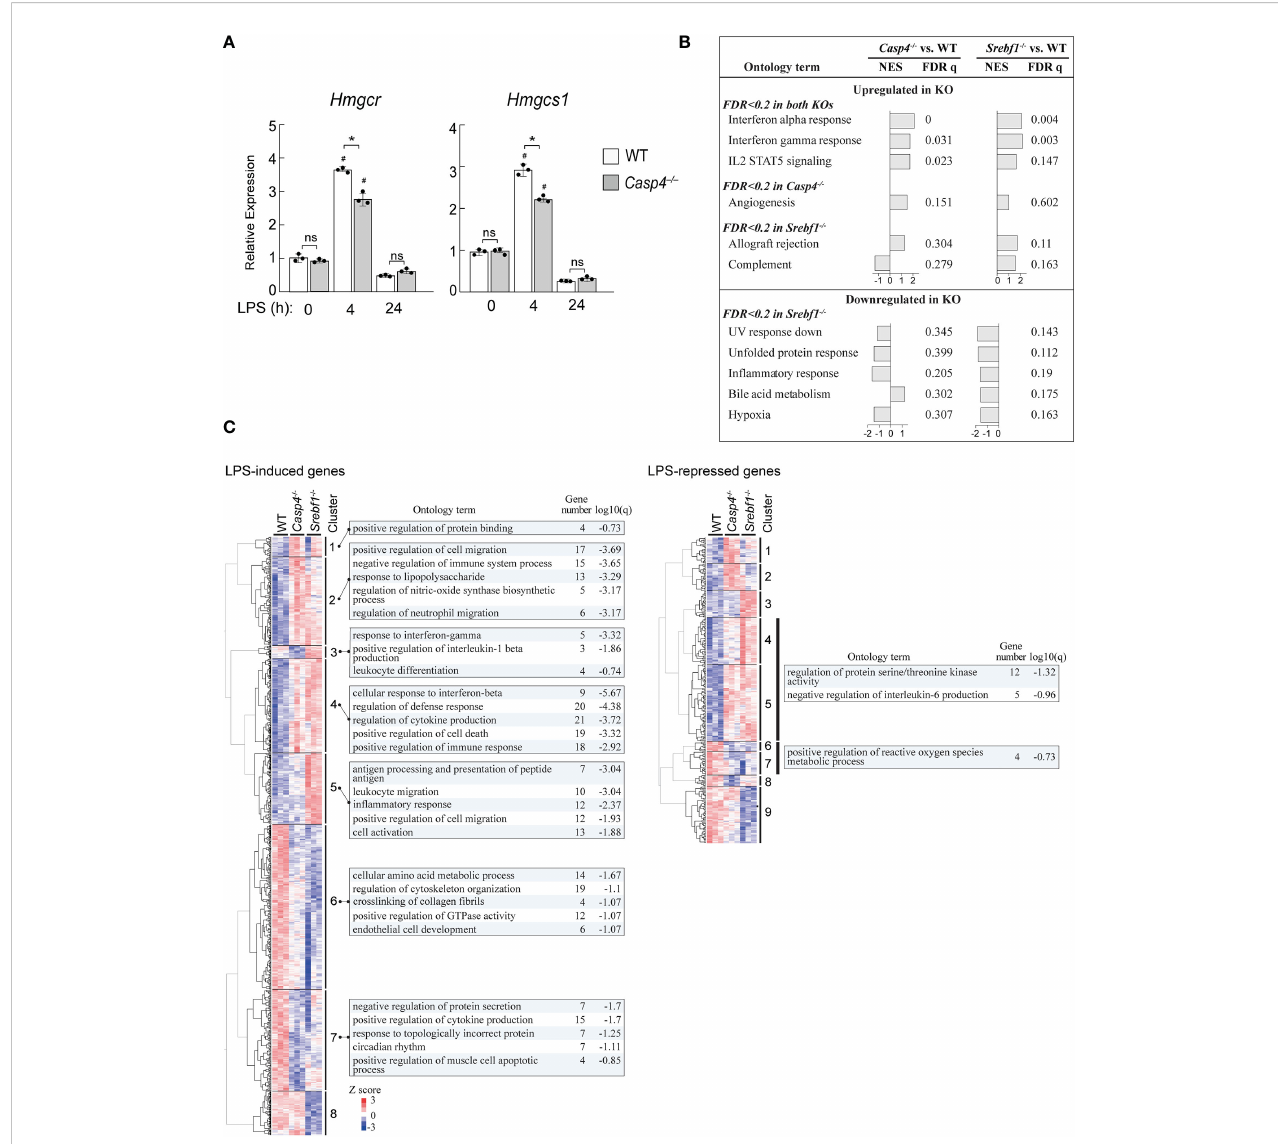
FIGURE 5 Casp4 and Srebf1 deletions affect LPS-dependent gene expression. (A) BMDMs obtained from WT or Casp4 -/- mice were stimulated with LPS for the indicated times. The mRNA expression levels of Hmgcr and Hmgcs1 were quanti fi ed by qPCR. mRNA levels were fi rst normalized to those of Gapdh and then to the expression levels of the target genes in untreated, WT BMDMs. The bars represent means ± SEM. n =3 for each time point. Signi fi cance was determined by one-way ANOVA followed by Tukey ’ s multiple comparison test. * P < 0.05, # P < 0.05 compared to the 0 h value for the same genotype. ns, not signi fi cant. (B, C) WT, Casp4 -/- , and Srebf1 -/- BMDMs were treated with LPS for 4 h and their transcriptomes were analyzed by RNA-seq. n =3 in each group. In B, enrichment analysis was performed using GSEA (47). MSigDB hallmark gene sets enriched in Casp4 -/- and/or Srebf1 -/- BMDMs compared to WT BMDMs (FDR < 0.2) are shown. NES, normalized enrichment score. Note that no gene sets reached FDR < 0.2 for Casp4 -/- BMDMs. In C, the expression levels of genes signi fi cantly (FDR < 0.05) upregulated or downregulated in WT BMDMs and differentially expressed between WT and either Casp4 -/- or Srebf1 -/- BMDMs treated with LPS for 4 h (FDR < 0.05) were hierarchically clustered. Heatmaps of the standardized expression levels of 870 LPS-induced and 294 LPS-repressed genes in each cell after 4 h of LPS are shown. The top 5 gene ontology terms or reactome gene sets enriched (FDR < 0.2) for each cluster are also shown. Gene number is the number of genes in the cluster with membership in the ontology term. Note that gene sets were not identi fi ed for each cluster of LPS-repressed genes. The sets of genes enriched in clusters 4 and 5 as well as 6 and 7 of the LPS-repressed genes are shown. Genes belonging to each cluster are shown in Supplemental Table